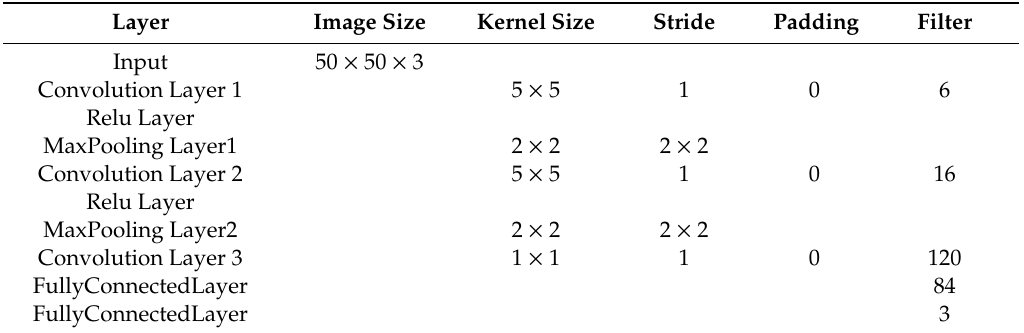
Figure 3. Convolutional neural network (CNN) structure. Table 2. The proposed CNN architecture.